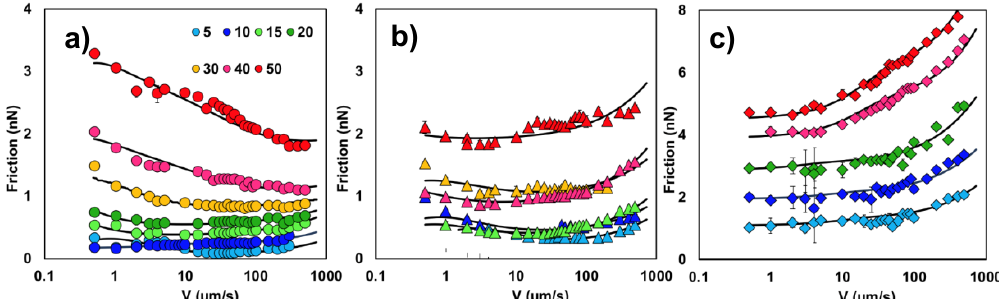
Figure 11. Friction force as a function of the sliding velocity for ( a ) 4% (circles), ( b ) 6% (triangles), and ( c ) 9% (diamonds) PAAm hydrogels at loads between 5 and 50 nN (see legend in ( a )). The black lines give the calculated friction force according to the viscous–adhesive model. Colloid diameter = 20 μm. Spring constant = 0.4 N/m. Note the different scales on the Y -axis of ( c ). Reprinted from Shoaib, T. and R.M. Espinosa-Marzal, Insight into the Viscous and Adhesive Contributions to Hydrogel Friction. Tribology Letters, 2018 , 66 , 96.